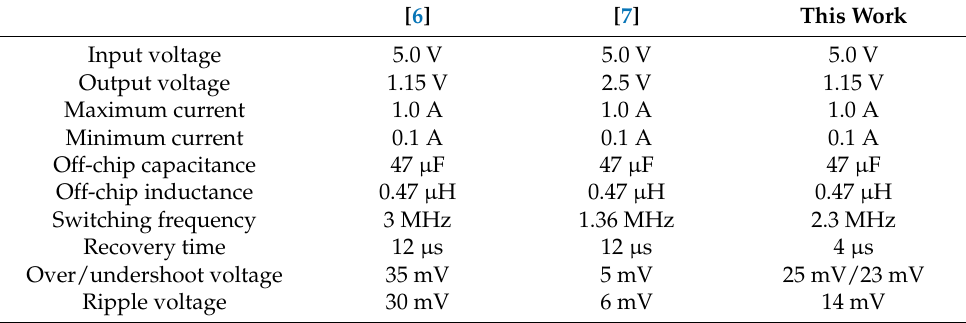
Table 2. Comparison with Yuan’s work.